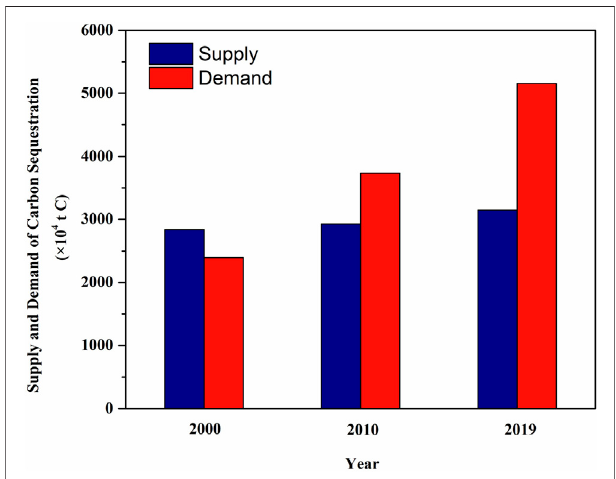
FIGURE 3 | The carbon sequestration supply and demand from 2000 to